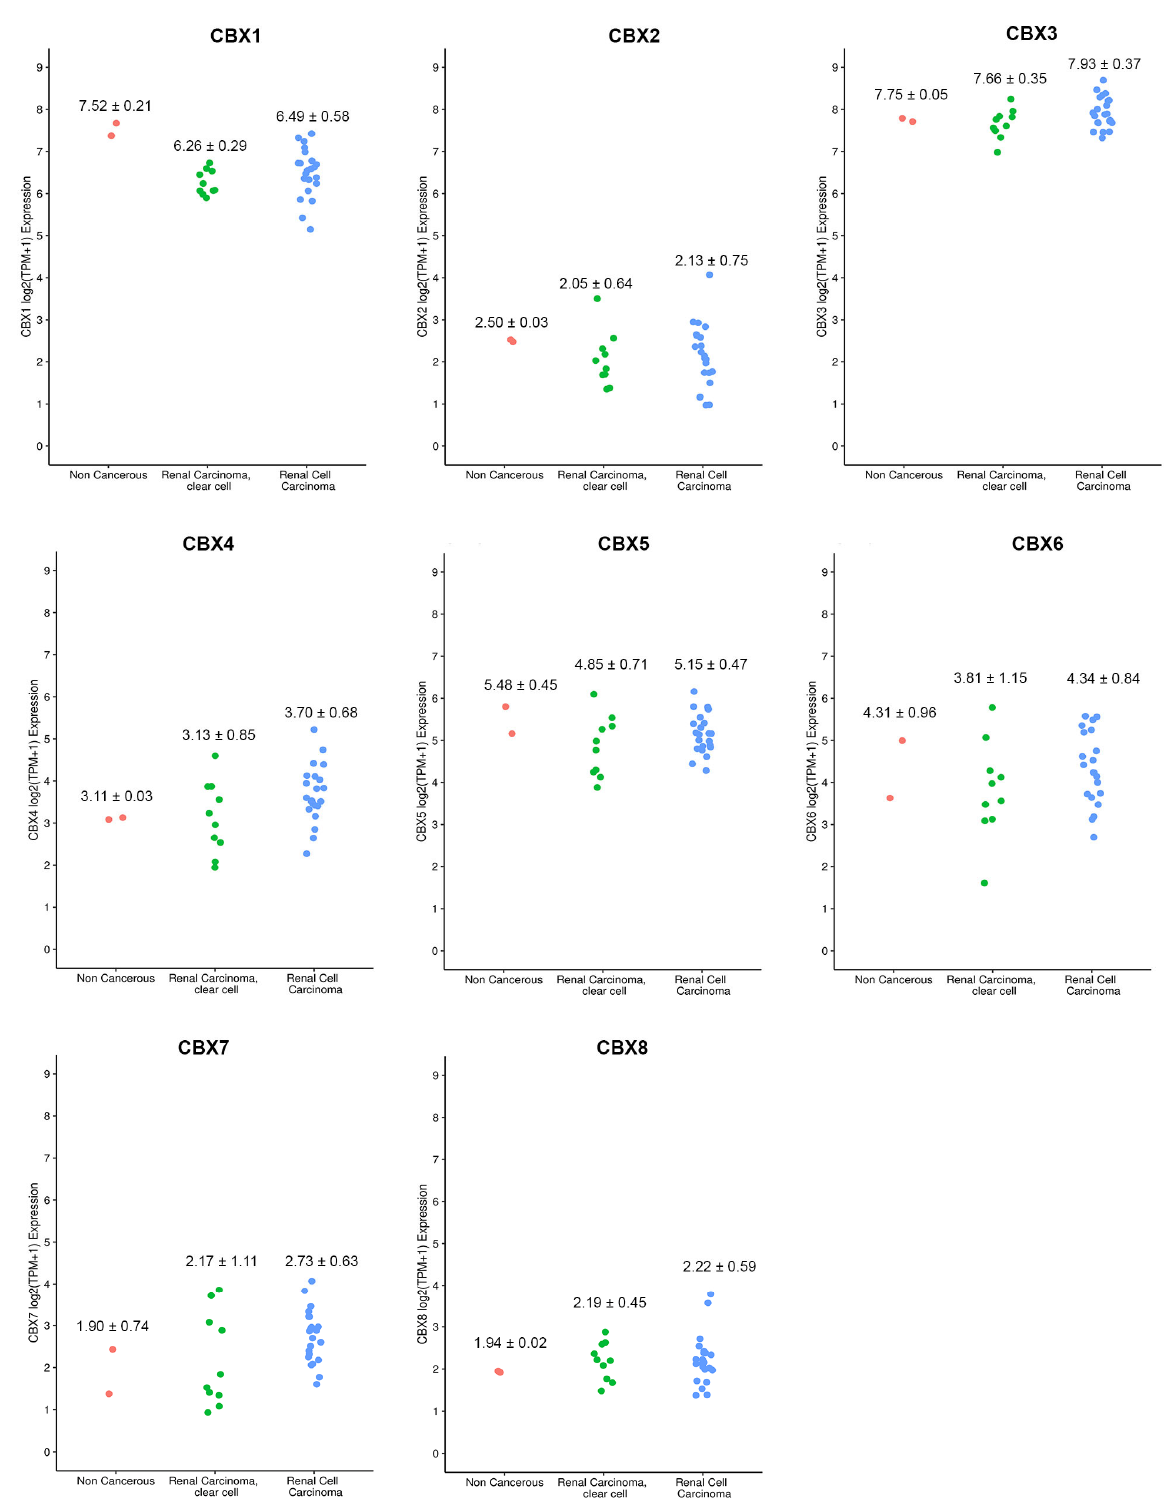
Figure 8. Distribution of gene expression values in non-cancerous, clear cell renal carcinoma, and renal cell carcinoma cell lines in different CBX genes. On the x-axis, the different kidney cell lines are reported; on the y-axis, the expression values for each cell line are shown. Each color identifies a specific cell type: pink for non-cancerous cell lines, green for clear cell line renal carcinoma, and blue for renal cell carcinoma. Each dot identifies a cell line (see Table S1). For each cell type, mean and standard deviation are also